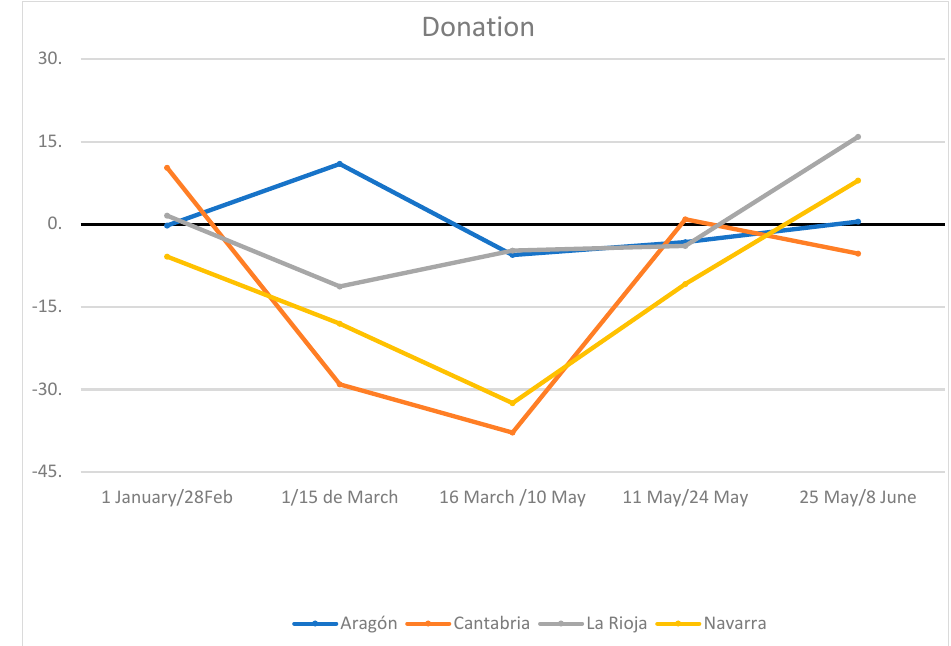
Figure 1. Evolution of donations. Percentage increase or decrease compared to the same time period of the previous biennium.